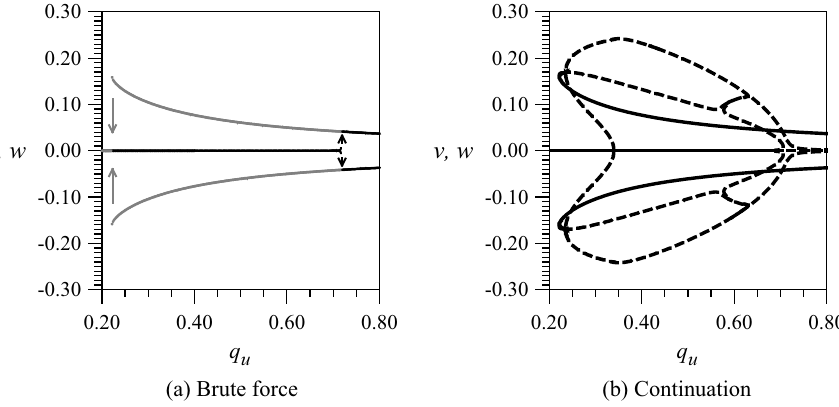
Fig. 10. Bifurcation diagram for the beam under harmonic axial forcing: q u cos(2 . 02 ω 0 t )